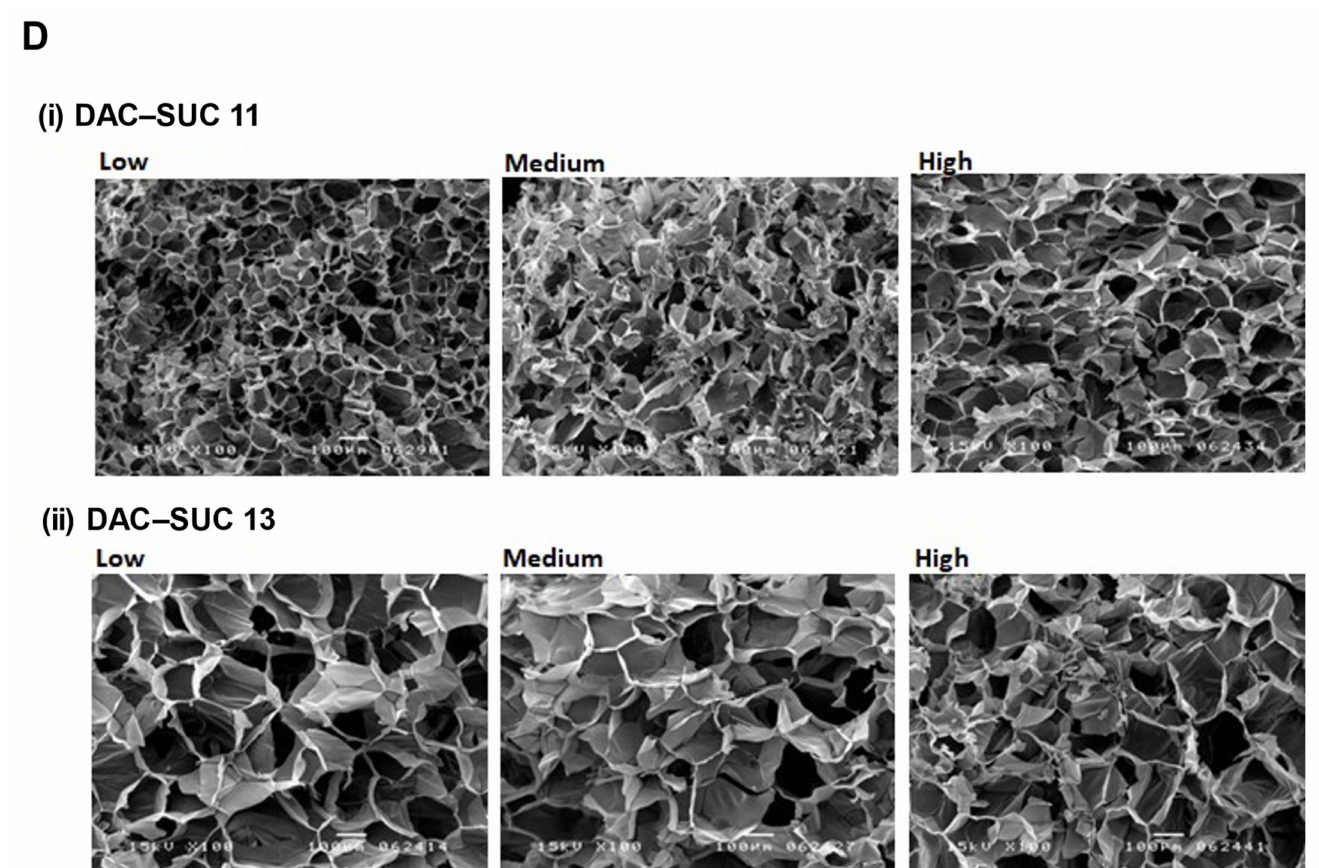
Figure 3. Cell-compatibility of DAC-SUC hydrogel. ( A ) Cells were treated with ( i ) DAC-SUC11 or ( ii ) DAC-SUC13 hydrogel extraction medium and then stained with LIVE/DEAD ® reagent. Most cells were shown green spots (alive) in Low DAC-SUC13 group. ( B ) Cells were encapsulated in ( i ) DAC-SUC11 or ( ii ) DAC-SUC13 hydrogels and then stained with LIVE/DEAD ® reagent. Most cells were shown green spots (alive) in Low DAC-SUC13 group. ( iii ) The 3D image of Low DAC- SUC13 hydrogel. ( C ) Cell viability ad cell death were evaluated. Results showed that cells were alive well in Low DAC-SUC13 hydrogel group. ( D ) SEM images of hydrogels. The hydrogels displayed a continuous and porous